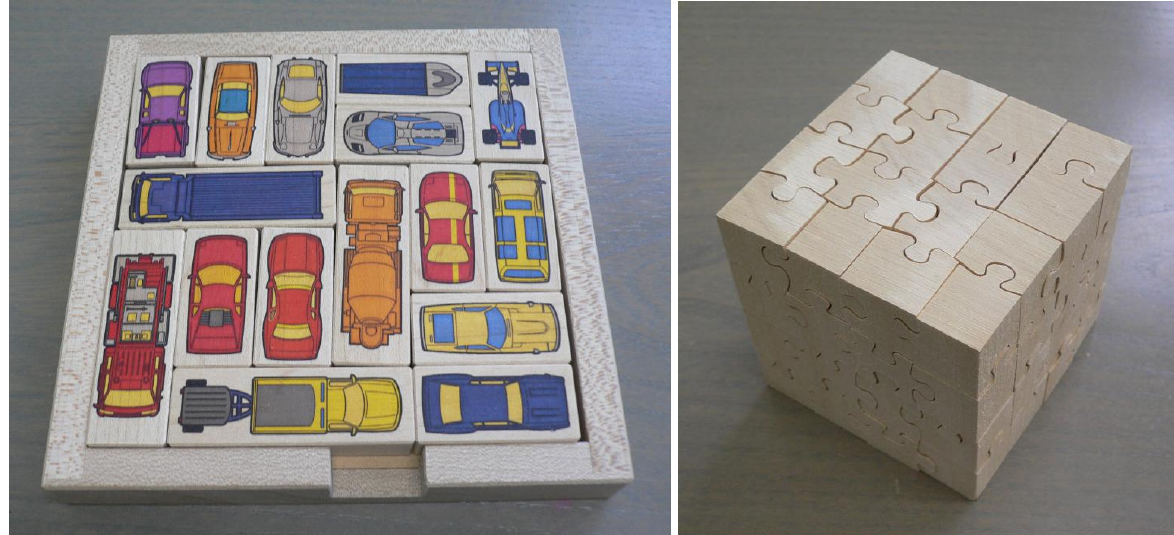
Figure 1. Typical sliding block puzzles in 2D and 3D.